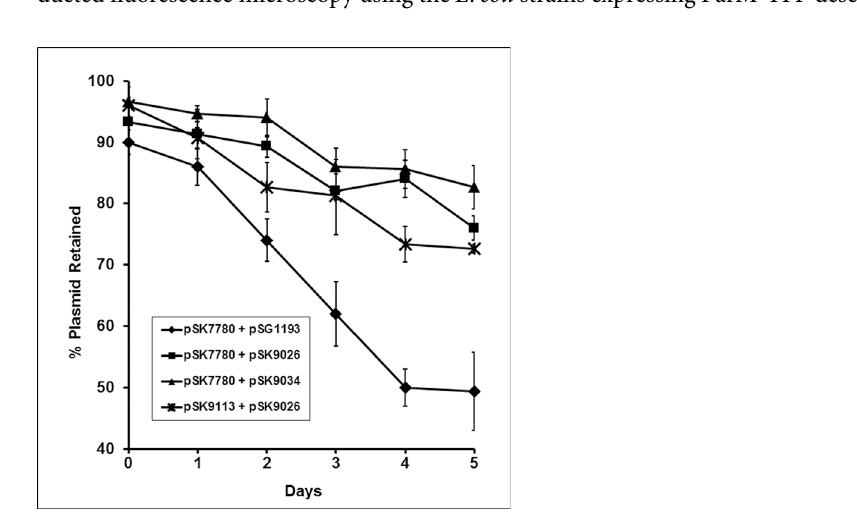
Fig 2. Segregational stability of parC -containing pSK7780 or pSK7780-derived test plasmids in the presence or absence of ParM or ParM-YFP in the E . coli DH5 α cells. The retention of pSK7780, containing the parC centromere and parR transcribed from P par was determined in the presence of pSK9026 (squares; expressing ParM-YFP), pSK9034 (triangles; expressing ParM which had been uncoupled from YFP), or pSG1193 (diamonds; expressing YFP only). The retention of pSK9113 (stars), containing parR transcribed from P par , but with parC cloned downstream from the parR ORF, was determined in the presence of pSK9026. Five days of serial subculture represents approximately 50 generations of growth. Each data point is the mean of three biological replicates. Standard error is